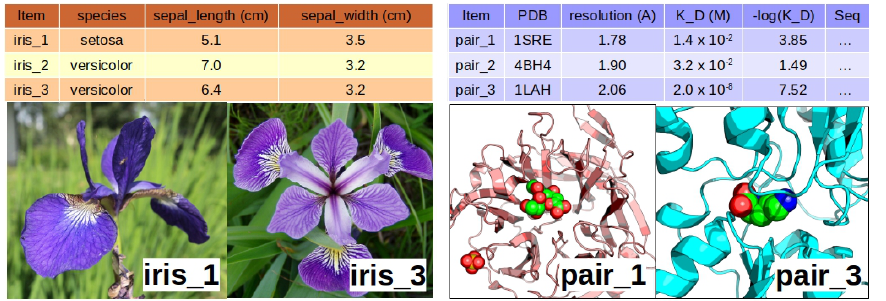
Figure 2. Schematic depiction of feature observation for an iris side-by-side with a protein–ligand pair. The iris might be given three features: species, sepal length (in cm), and sepal width (in cm). The protein–ligand pair might be given two features: combined molecular weight MW and kinetic inhibitory constant K i . Iris images: left : Tiia Monto (CC-BA-SA), right : Danielle Langlois (CC-BA-SA). Protein images generated using